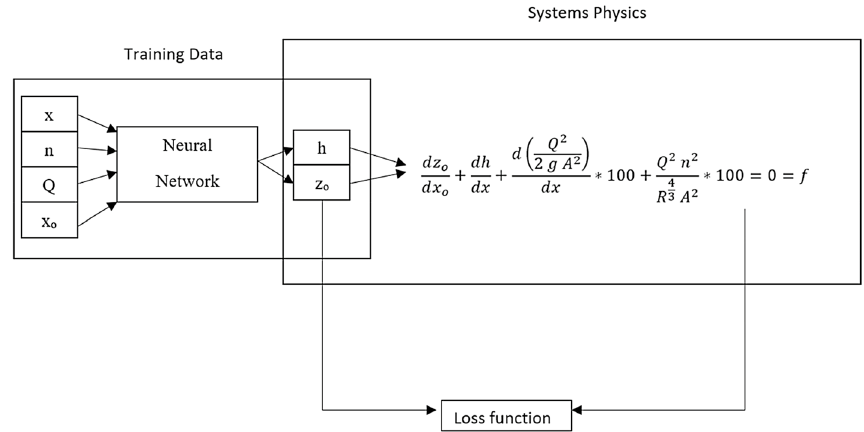
Fig. 3 Physics‑Informed Deep Learning